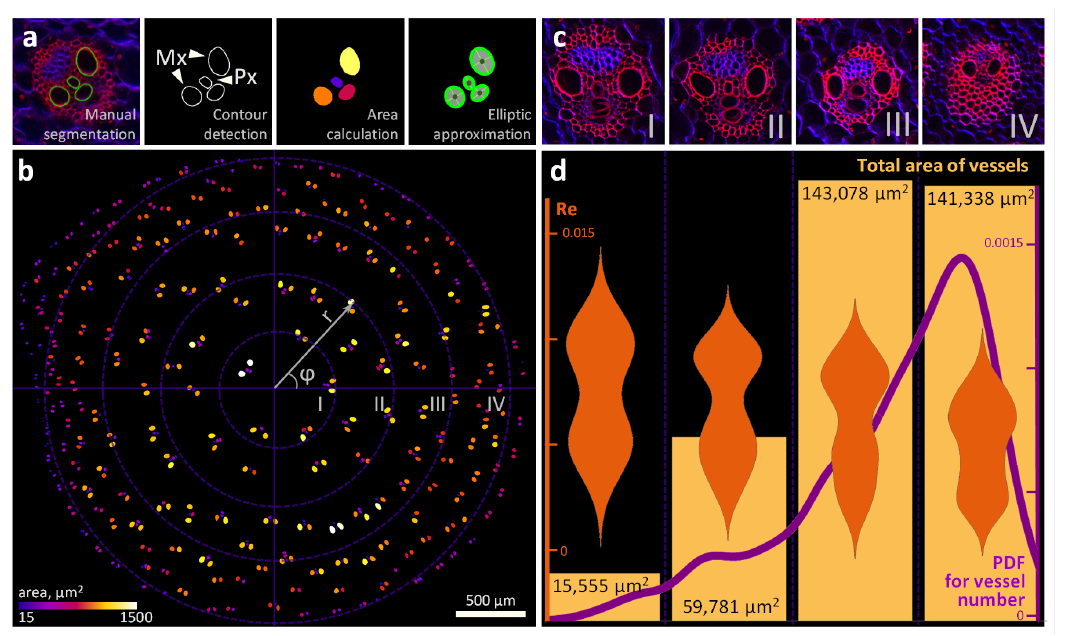
Figure 5. LSM image-based determination of numerical characteristics for Reynolds number-based matching between the xylem vessels in the maize stem and the microchannels in the lab-on-a-chip model. ( a ) The main stages of LSM image processing for obtaining data on the spatial distribution of the dimensional characteristics of the xylem vessels (metaxylem (Mx) and protoxylem (Px)) in the internode of the maize stem, including expert manual segmentation, contour extraction, calculation of cross-sectional areas, and ellipse fitting. ( b ) The location of the xylem vessels on the cross section of the maize stem in the I, II, III, or IV “rings”; the coordinates were recalculated into the polar system relative to the nominal center of the stem; the color indicates the cross section of the vessel area. ( c ) LSM images for typical xylem bundles located in the I, II, III, and IV “rings”. ( d ) For xylem bundles located in the I, II, III, and IV “rings”, the distribution of vessels relative to the center of the stem, the total cross-sectional areas, and violin plots for Reynolds numbers ( Re